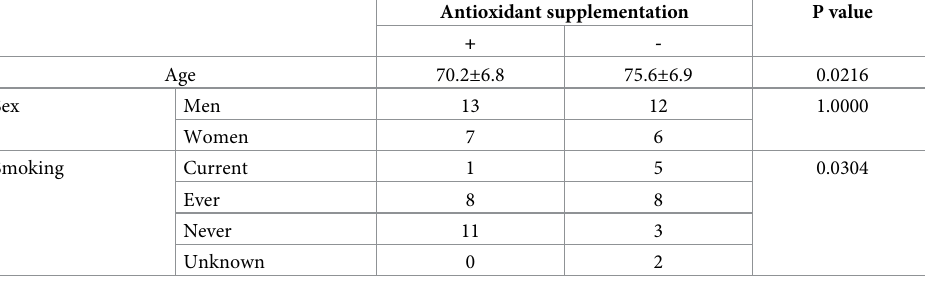
Table 5. Characteristics of patients with or without